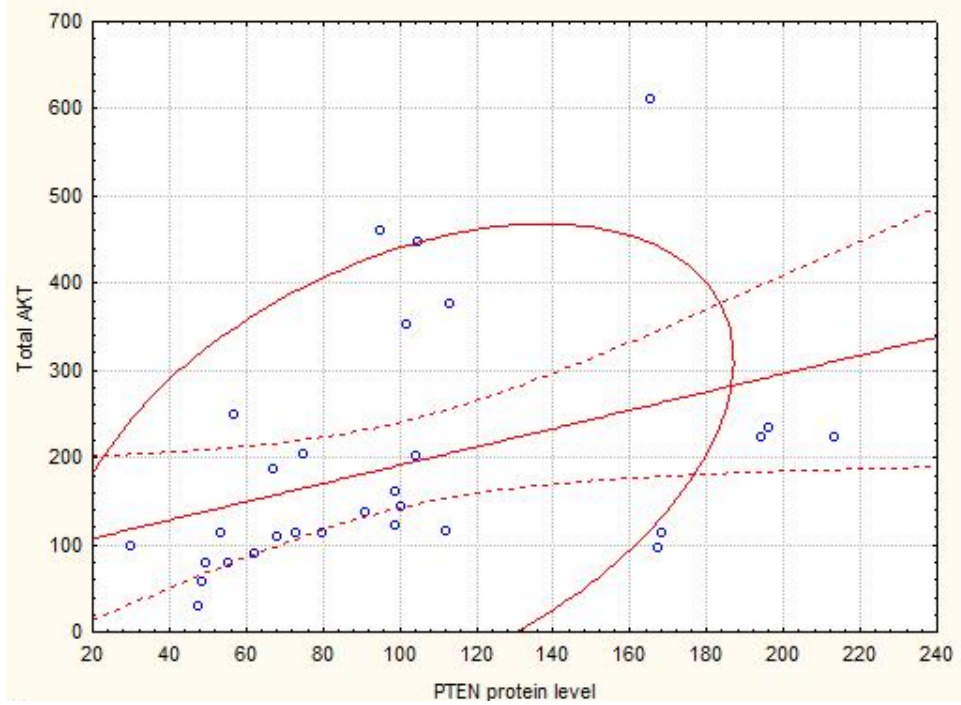
Figure 1. Scatterplot of PTEN and total AKT protein level in kidney cancers. Note: We found the associations between the protein level of PTEN with a total AKT (AKT pan) level in the primary tumors ( r = 0.54; p = 0.0005), indicating the phosphatase influence on downstream of intracellular signaling.